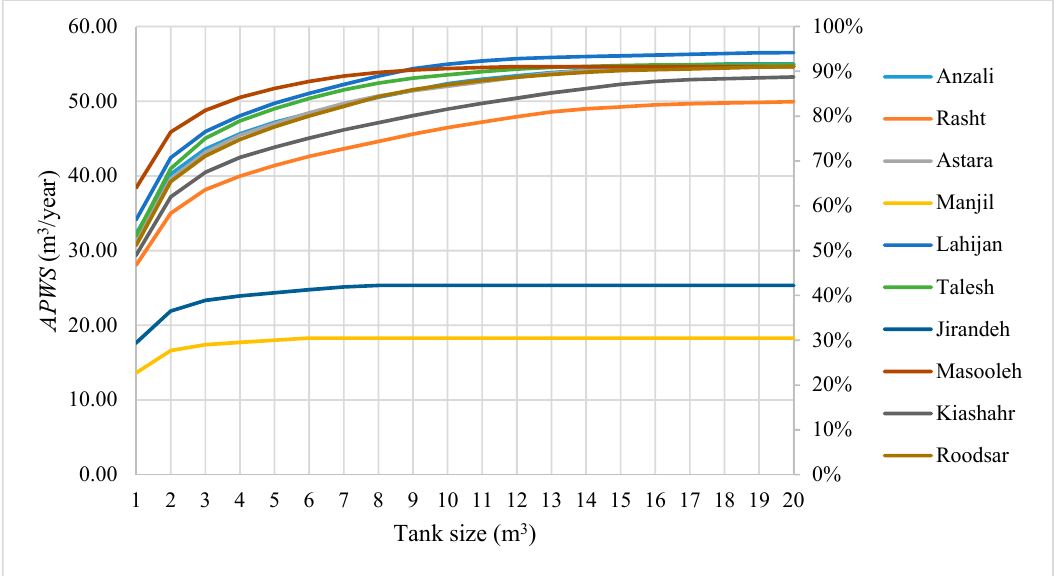
Figure 5. The relation between tank size and APWS for all stations (Scenario B).